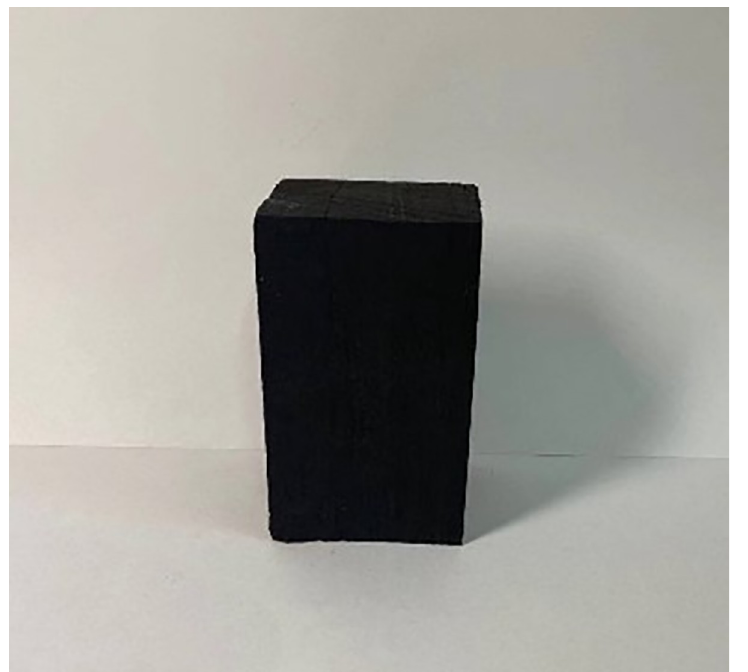
Fig 1. Experimental coal